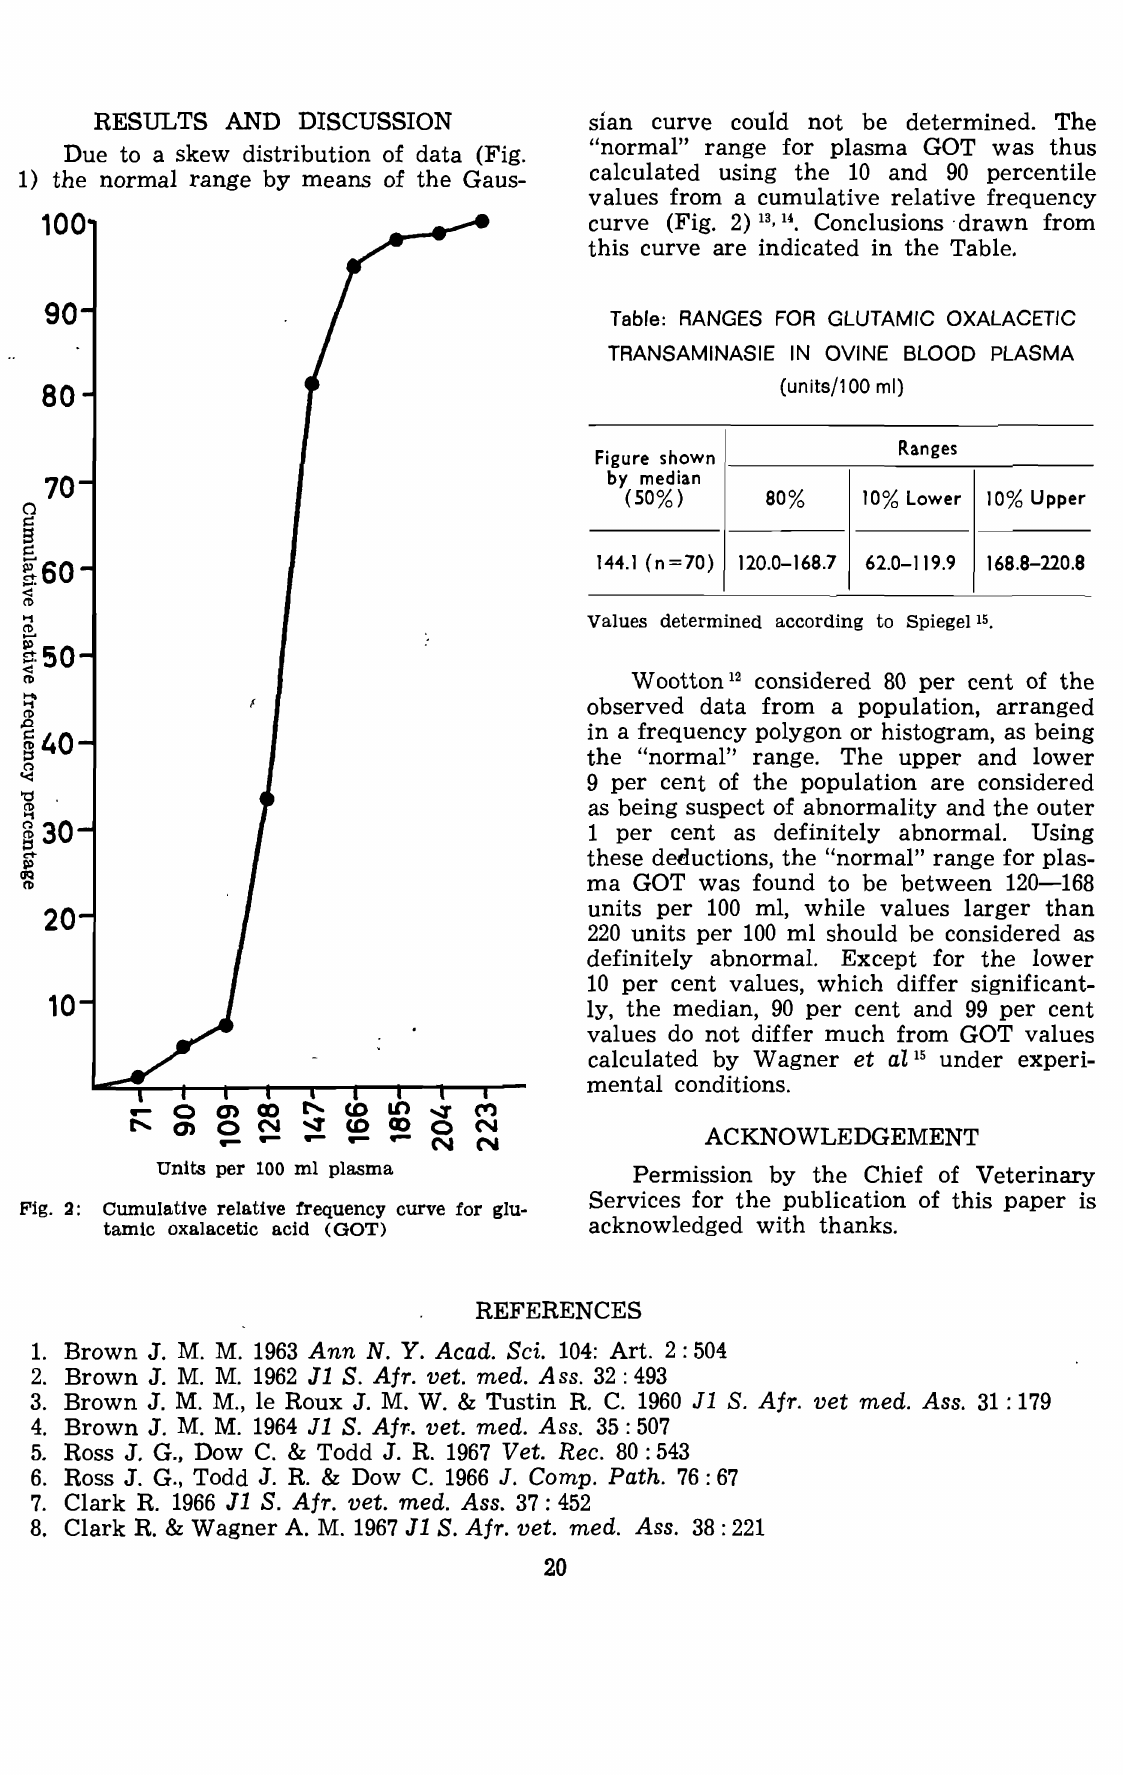
Table: RANGES FOR GLUTAMIC